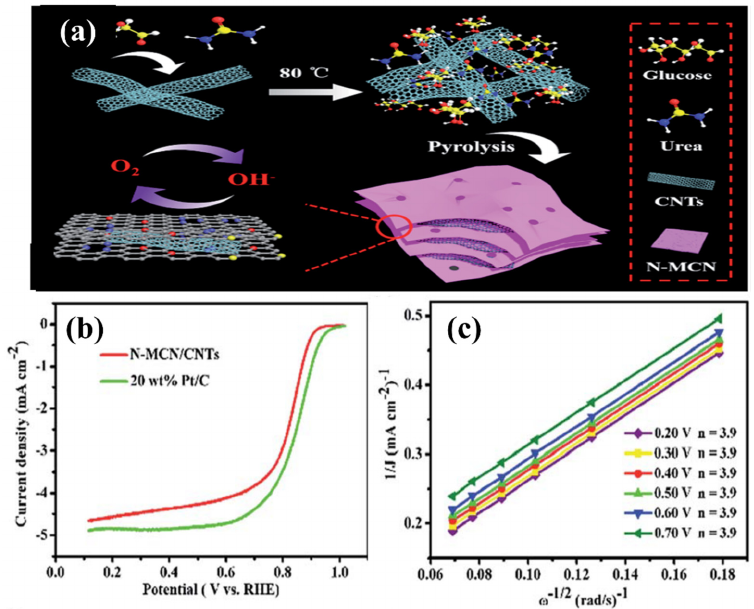
Figure 9. ( a ) Schematic for the synthesis of N-MCN/CNTs and the corresponding structural model, ( b ) LSV comparison of N-MCN/CNTs and Pt/C in an O 2 -saturated 0.1 M KOH solution at a rotation rate of 1600 rpm, ( c ) K–L plots of N-MCN/CNTs at indicated potentials, adapted from [62].